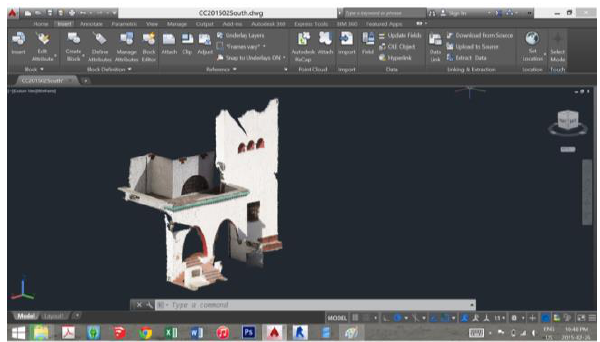
Fig.10 Screenshot of the Photogrammetric model of the south façade imported into AutoCAD 2014.